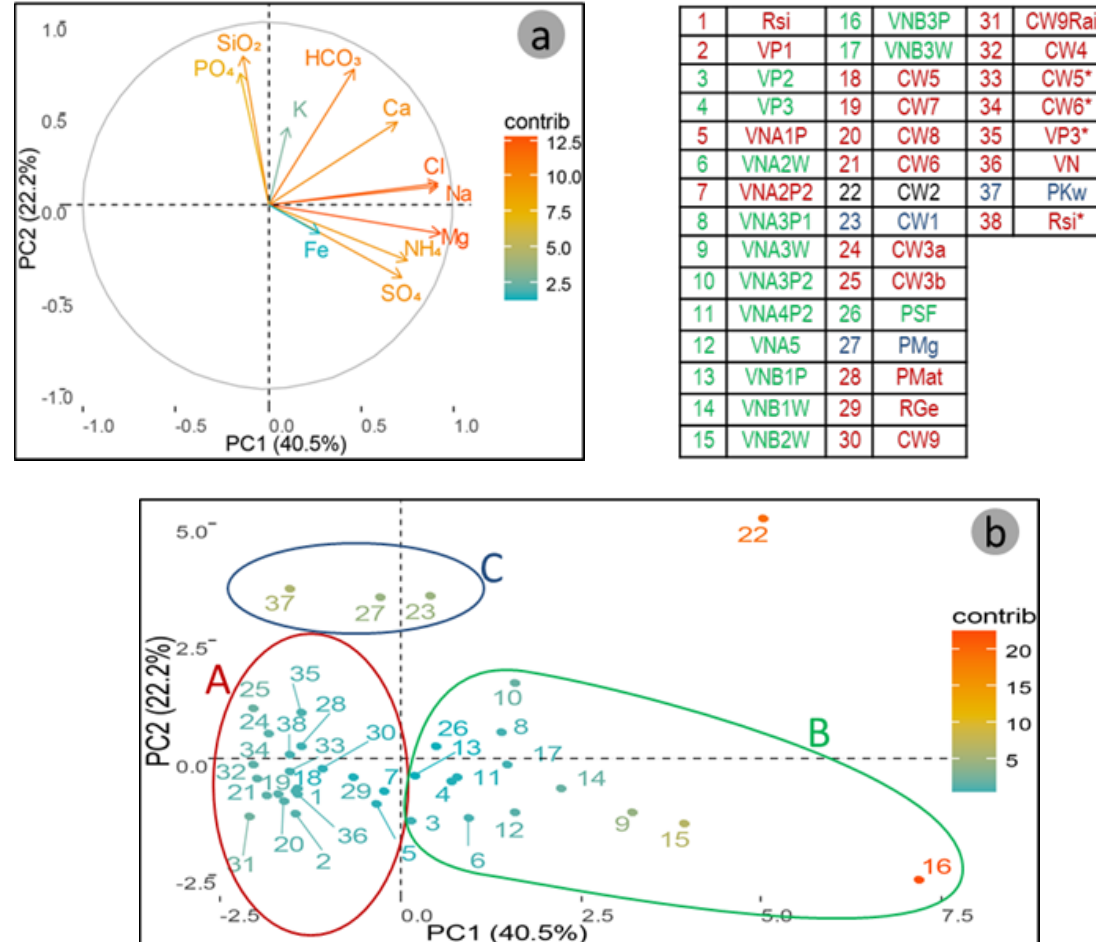
Figure 6. PCA of water ion composition based on the first two principal components (PC1 and PC2): (a) the contribution of variables (ions) to the first two PCs, where arrow length indicates the magnitude and arrow direction indicates which PC axis received the greatest contribution; (b) the distribution of the samples along PC1 and PC2, where the axis units express the magnitude of variation along the principal component.